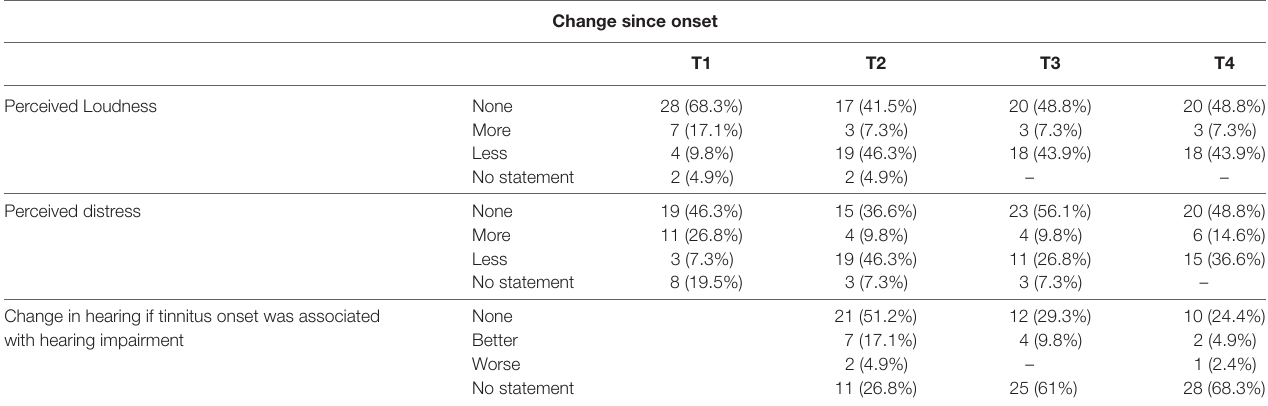
TaBle 4 | Response to question whether tinnitus had changed since onset.